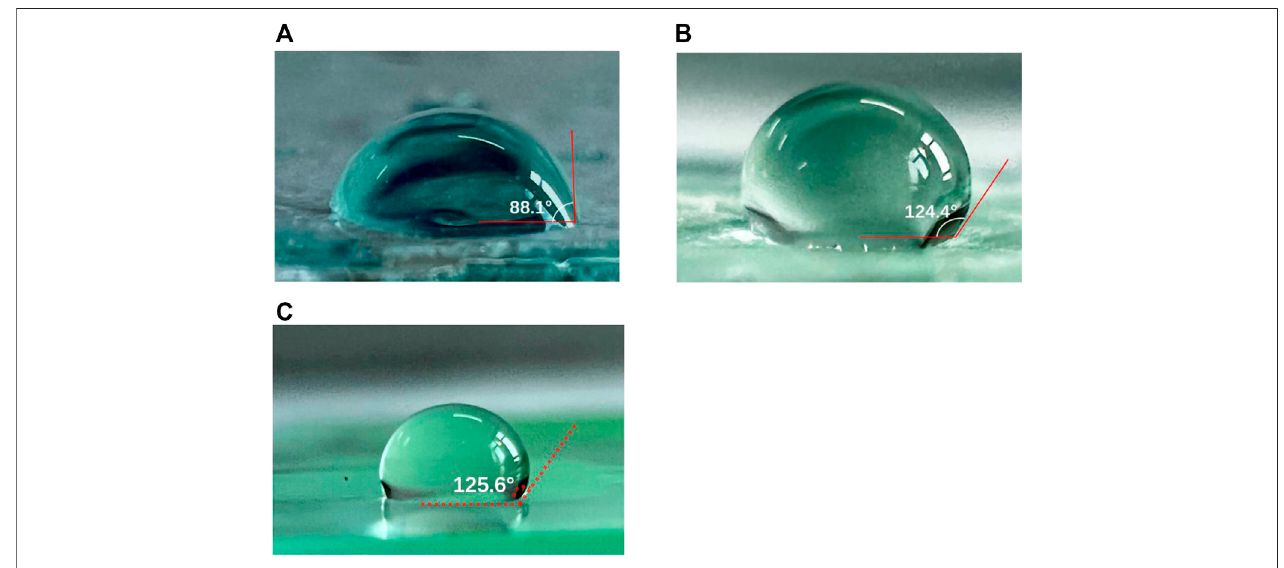
FIGURE 1 | Contact angles of water onto EVA (A) , paraf fi n (B) and paraf fi n/EVA/paraf fi n fi lms (C) .